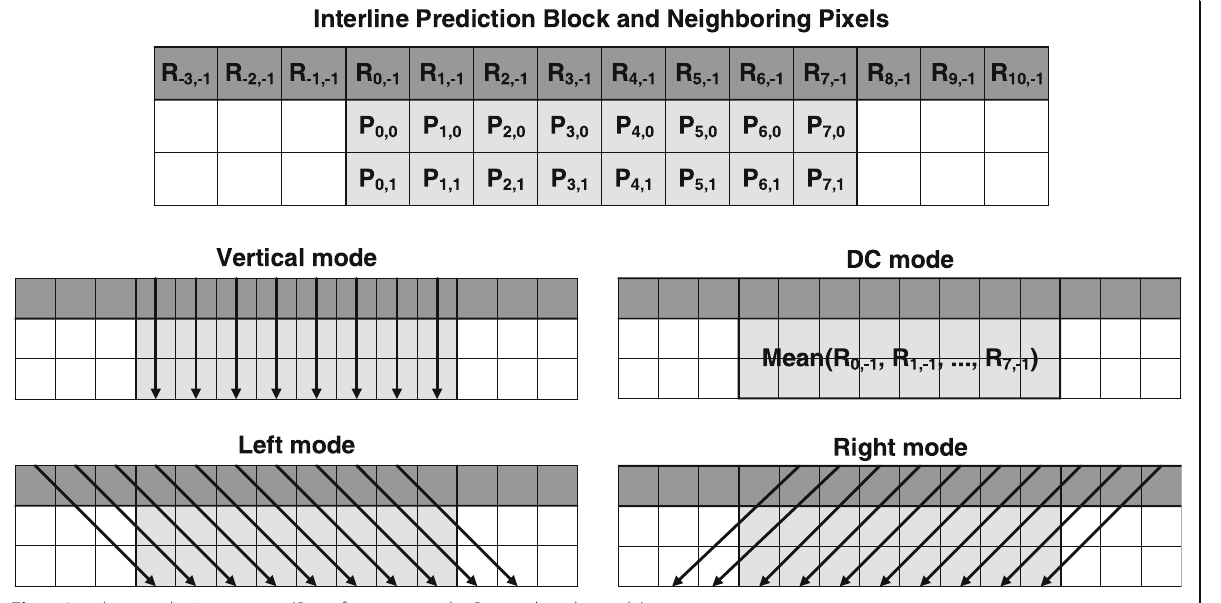
Fig. 5 Interline prediction process ( R x,y reference sample, P x,y predicted sample)